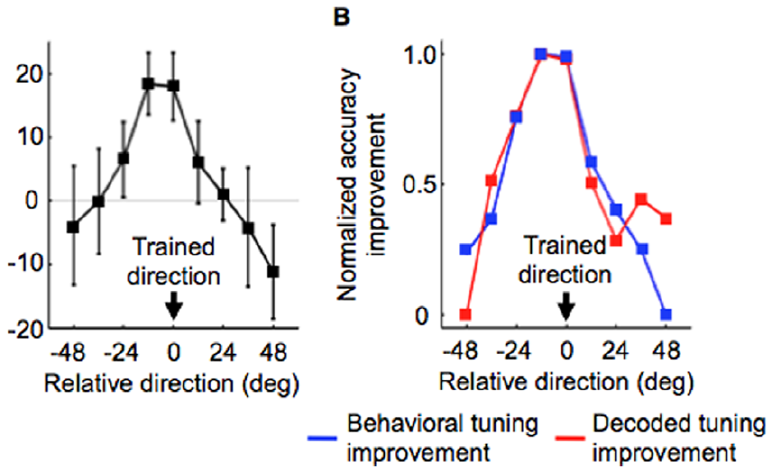
Figure 2. Comparing the two tuning improvement functions. (A) A behavioral tuning improvement function. The behavioral tuning improvement function was defined by mean performance change across the subjects between the pre- and post-test stages for each of 9 motion directions. Error bars represent SEM. (B) Comparison between the behavioral tuning improvement function (blue) and decoded tuning improvement function for V3A (red). Each improvement function was scaled from 0 to 1 for visualization purpose. Between the two improvement functions, a significant correlation was found ( r= 0.86, P , 0.05, multiple correction by the number of ROIs with false discovery rate).